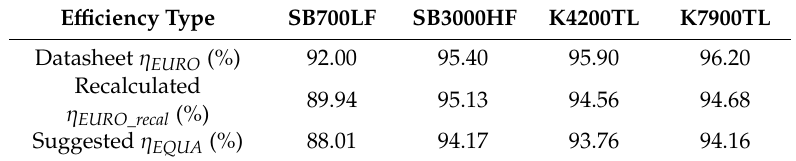
Table 10. Di ff erences between η EURO from datasheet, recalculated η EURO , and suggested η EQUA .